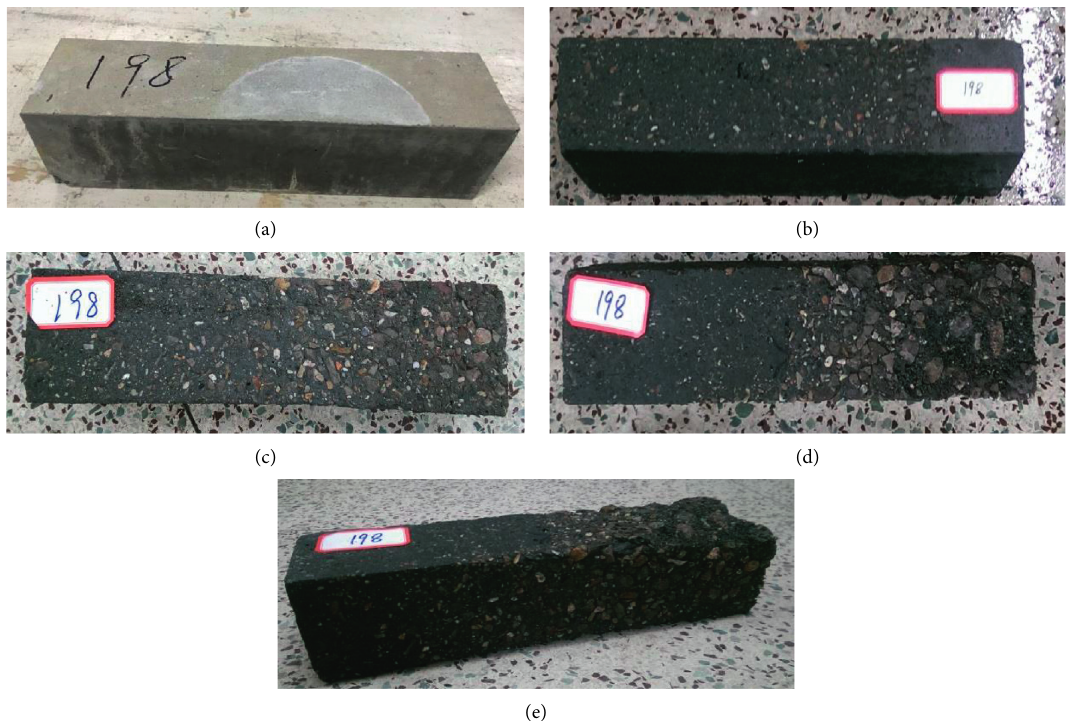
Figure 2: Typical failure modes of the concrete in the MFT environment. (a) 0 freeze-thaw cycles; (b) 25 freeze-thaw cycles; (c) 50 freeze- thaw cycles; (d) 75 freeze-thaw cycles; and (e) 100 freeze-thaw